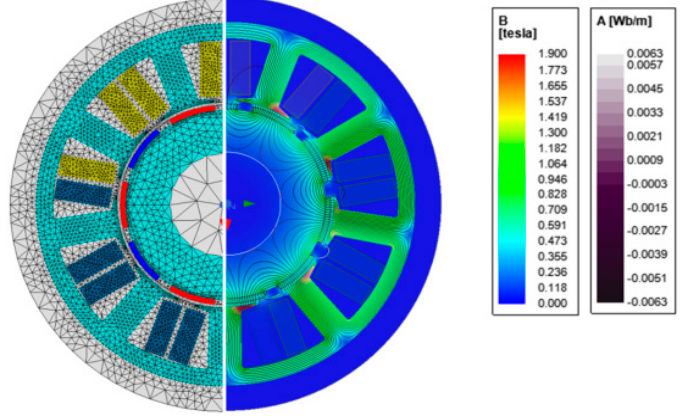
Figure 3. Applied FE mesh and exemplary plot of magnetic flux density.